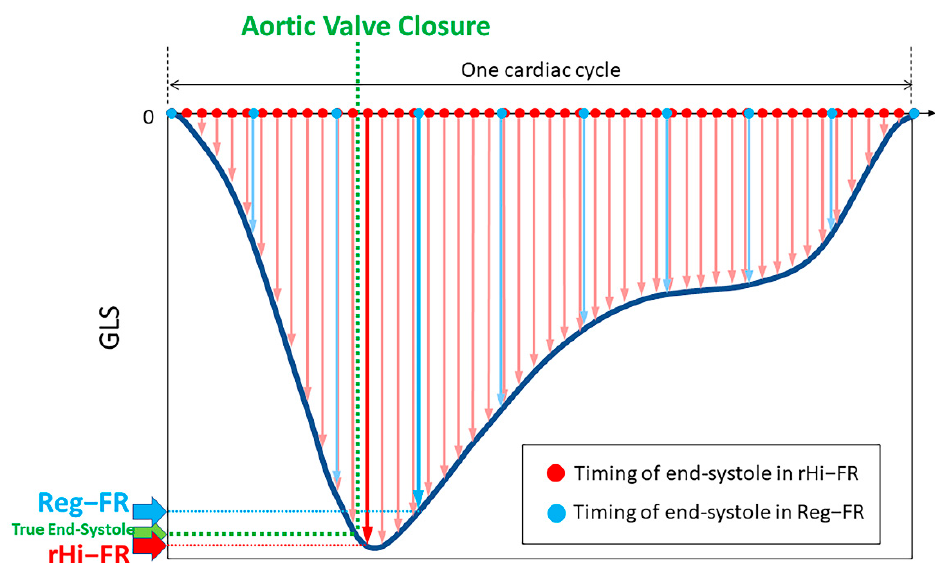
Figure 5. A schematic example of GLS values in rHi-FR and Reg-FR. The dark blue line represents an optimal GLS curve. In this schematic example, the GLS value in rHi-FR is larger and closer to the value at true end-systole compared with the value in Reg-FR. GLS, global longitudinal strain; rHi-FR, relatively high frame rate; Reg-FR, regular frame